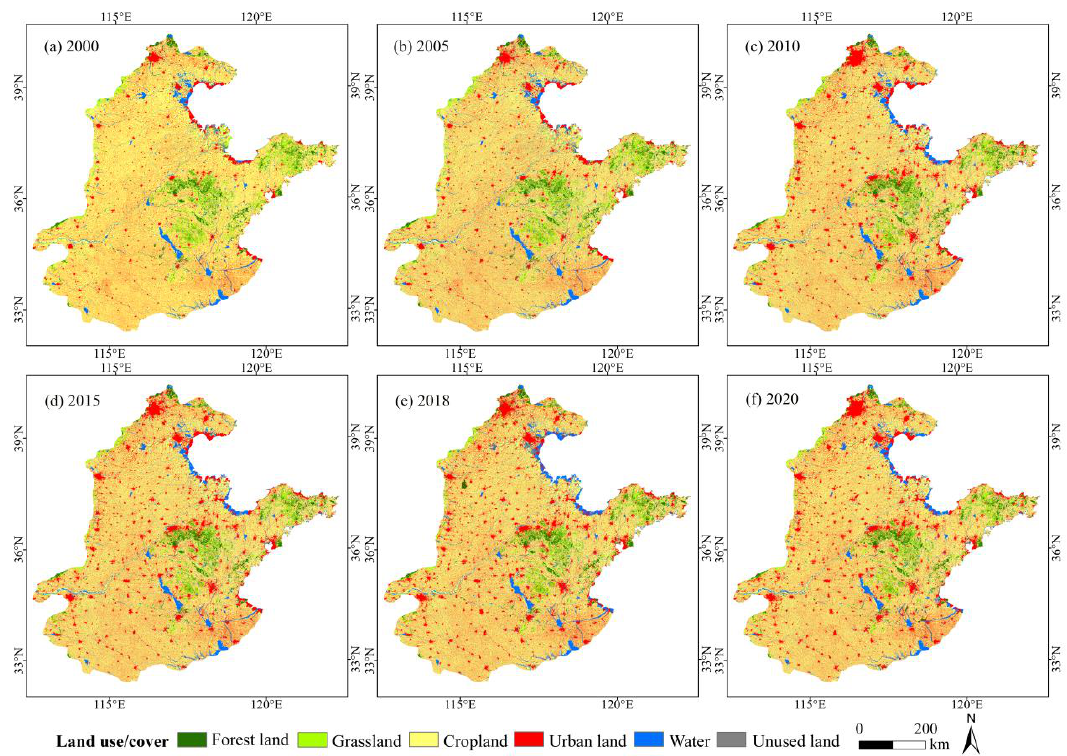
Figure 2. Land use/cover in HHHP in 2000 ( a ), 2005 ( b ), 2010 ( c ), 2015 ( d ), 2018 ( e ) and 2020 ( f ).